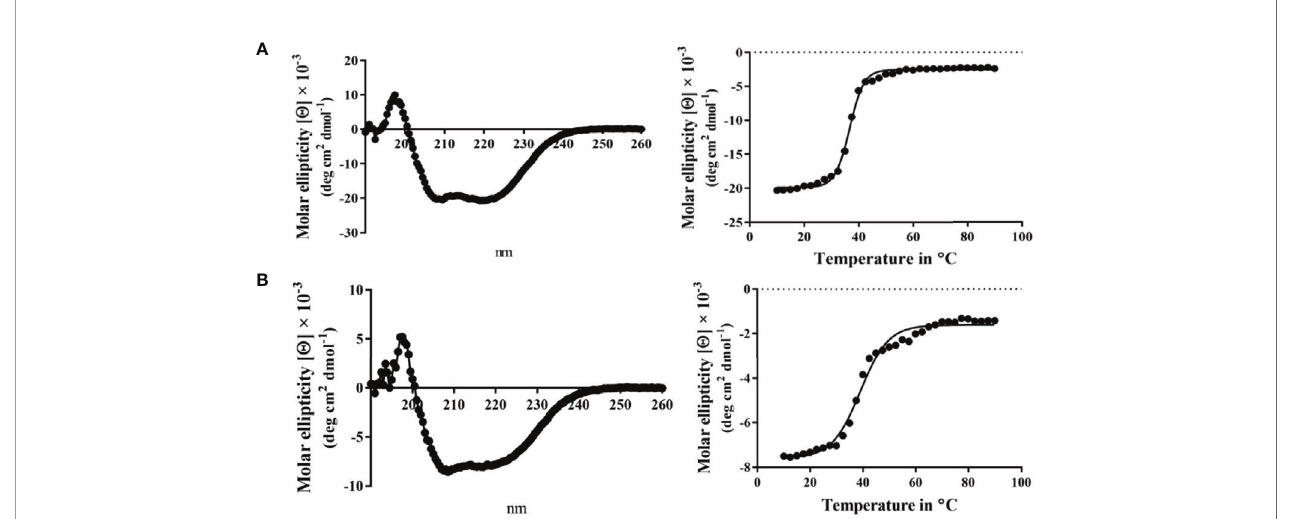
FIGURE 5 | CD spectra from MxiN and the Spa33-MxiN complex. The secondary structures and thermal stabilities of MxiN and its complex with the wild-type Spa33 heterotrimer were analyzed by CD spectroscopy. (A) The CD spectrum of MxiN alone shows two minima that indicate a rich a -helical structure (left). The thermal stability for MxiN was determined by plotting the molar ellipticity at 222 nm as a function of temperature. A single transition was observed giving a Tm value of 36.63°C (right). (B) The CD spectrum for the MxiN-Spa33 complex also had two minima with the stronger minimum at 208 nm, indicating a greater b -structure content than for MxiN alone (left). The thermal stability of the complex was tested by monitoring the molar ellipticity at 222 with increasing temperature. The complex had a major transition with a Tm value of 38.99°C, however, a minor second transition was seen at about 60°C (right). R 2 values for these unfolding curves was